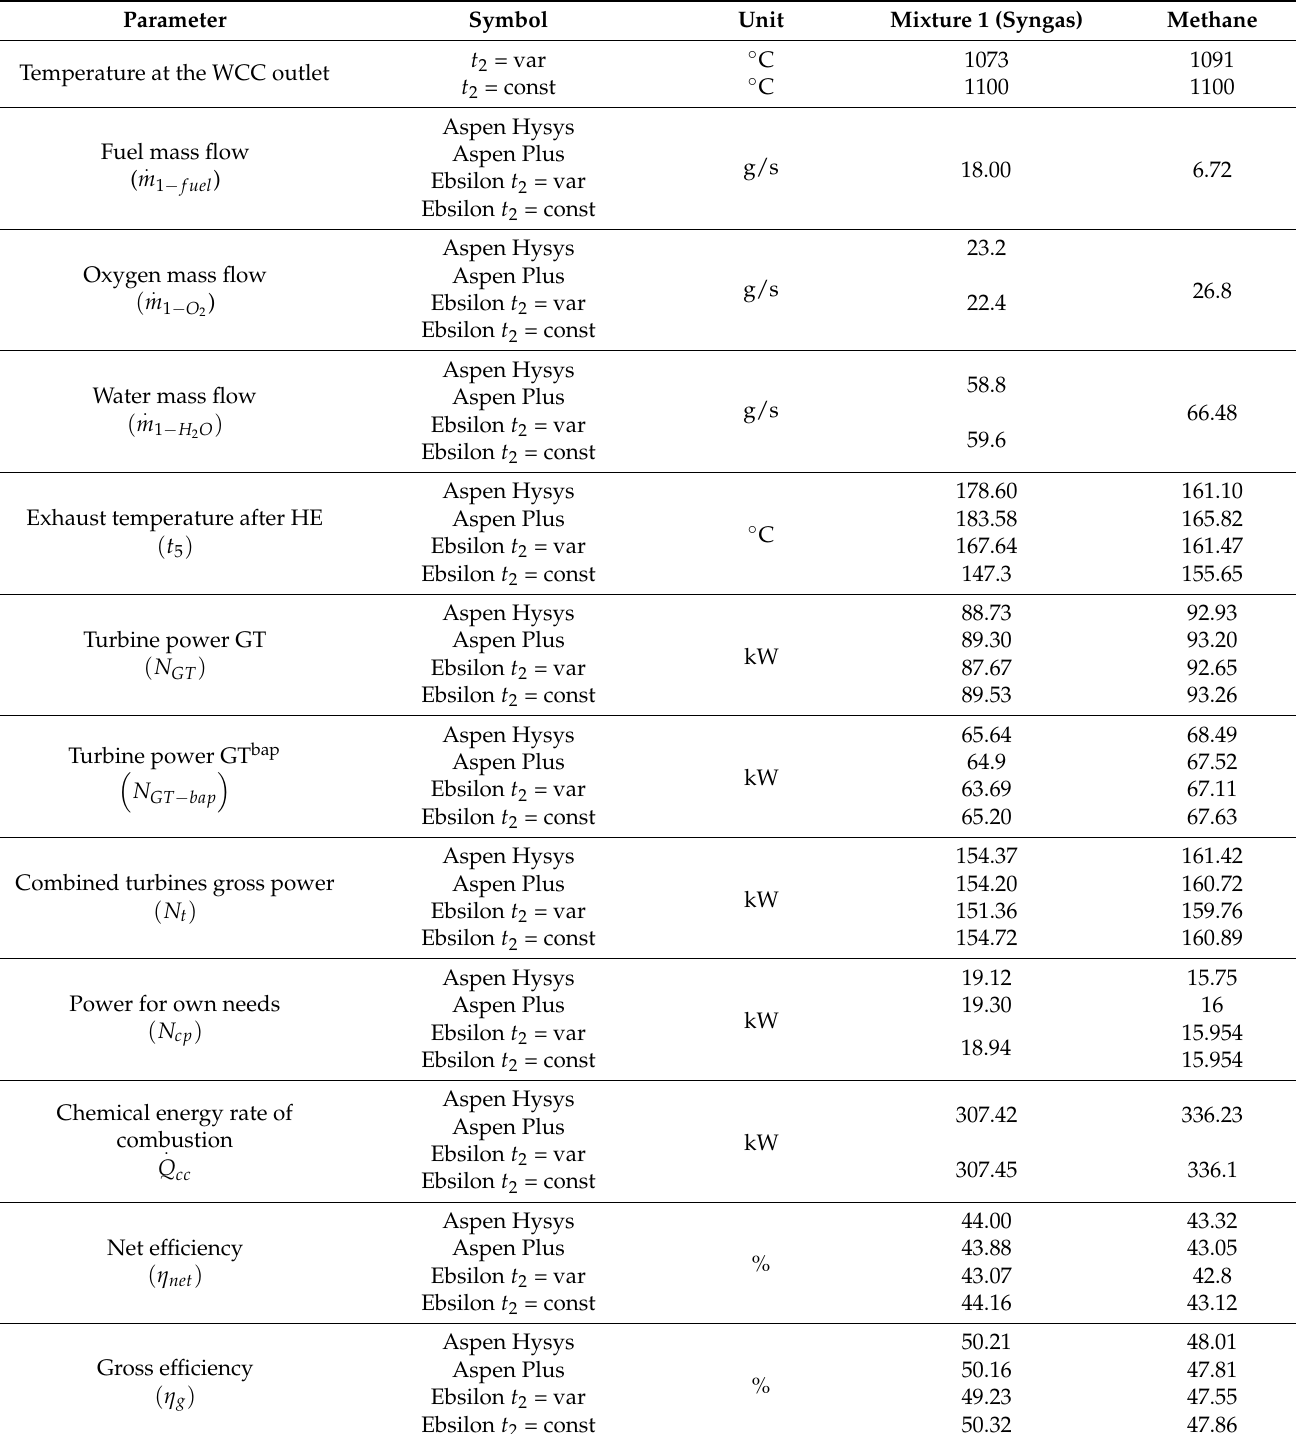
Table 9. Effect of different